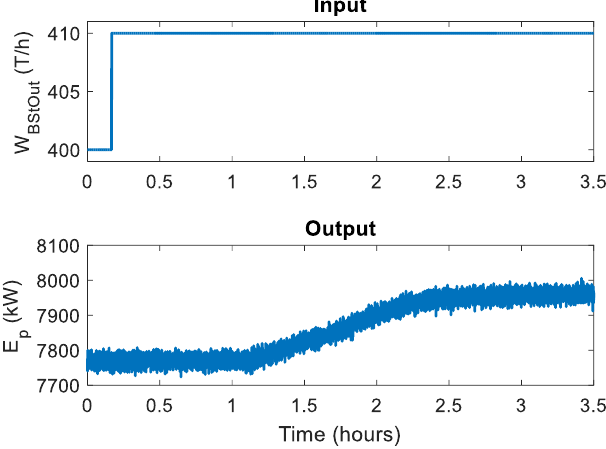
Figure 4. Dynamic response of E p for a step in W BStOut